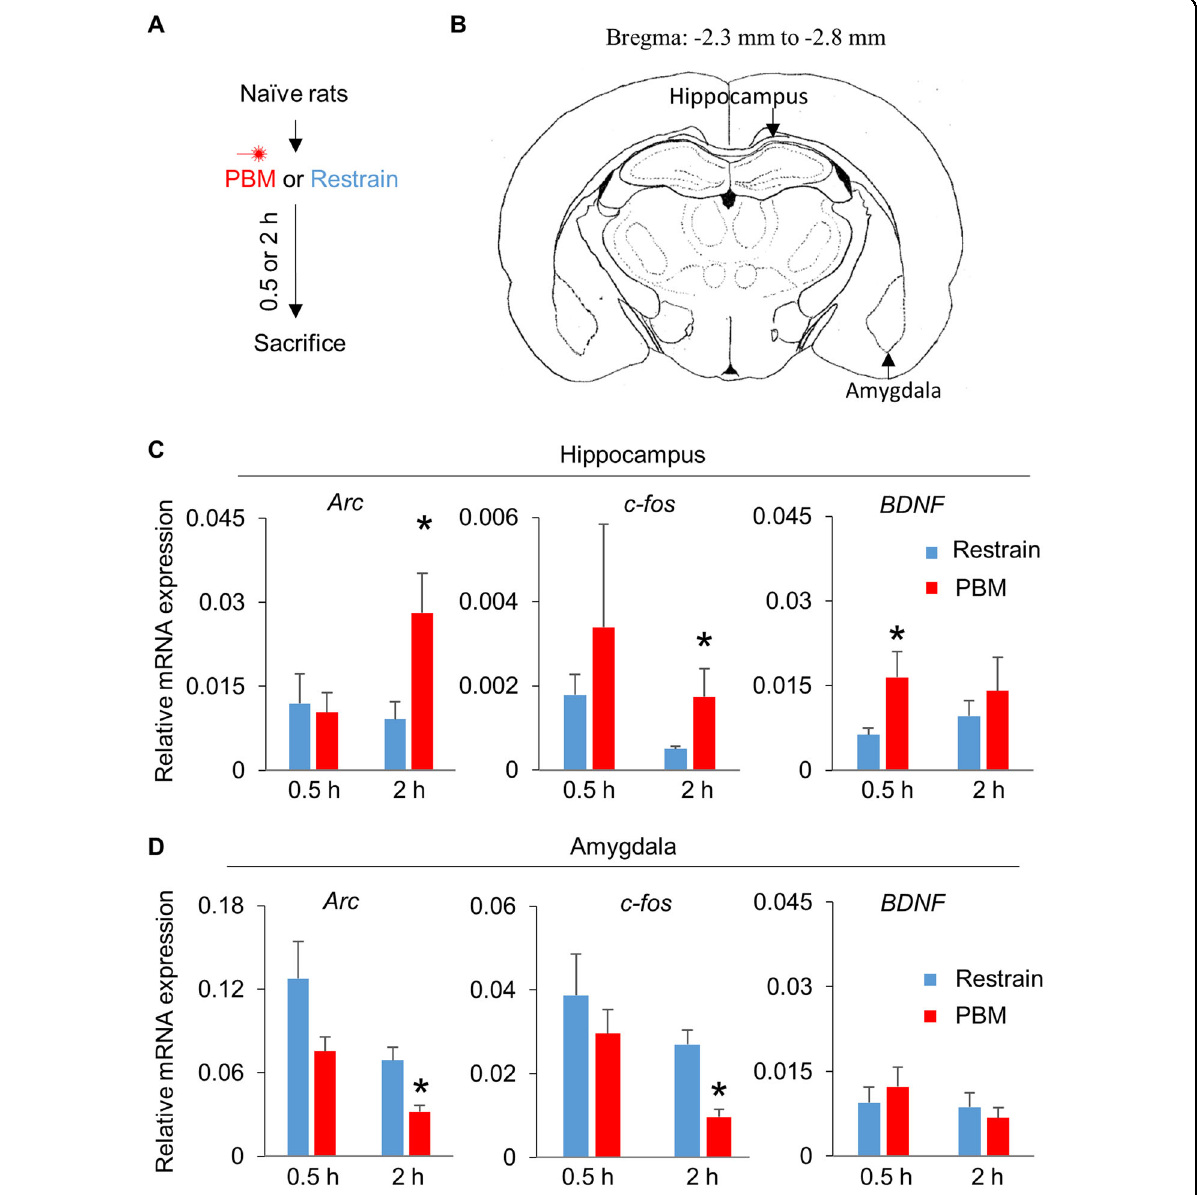
Fig. 4 PBM induced Arc , c-fos , and BNDF transcription in the hippocampus, and repressed Arc , c-fos expression in the amygdala. A Naive rats were restrained along with or without PBM, and then were sacri fi ced at 0.5 h and 2 h post PBM. B Brain atlas for collecting hippocampus and amygdala tissue. C PBM treatment increased Arc , c-fos , and BNDF transcription in the hippocampus. D PBM inhibited Arc and c-fos expression in the amygdala. n = 7, 7 for Res, PBM-group at 0.5 h, respectively; n = 7, 6 for Res, PBM-group at 2 h, respectively. * P < 0.05 versus